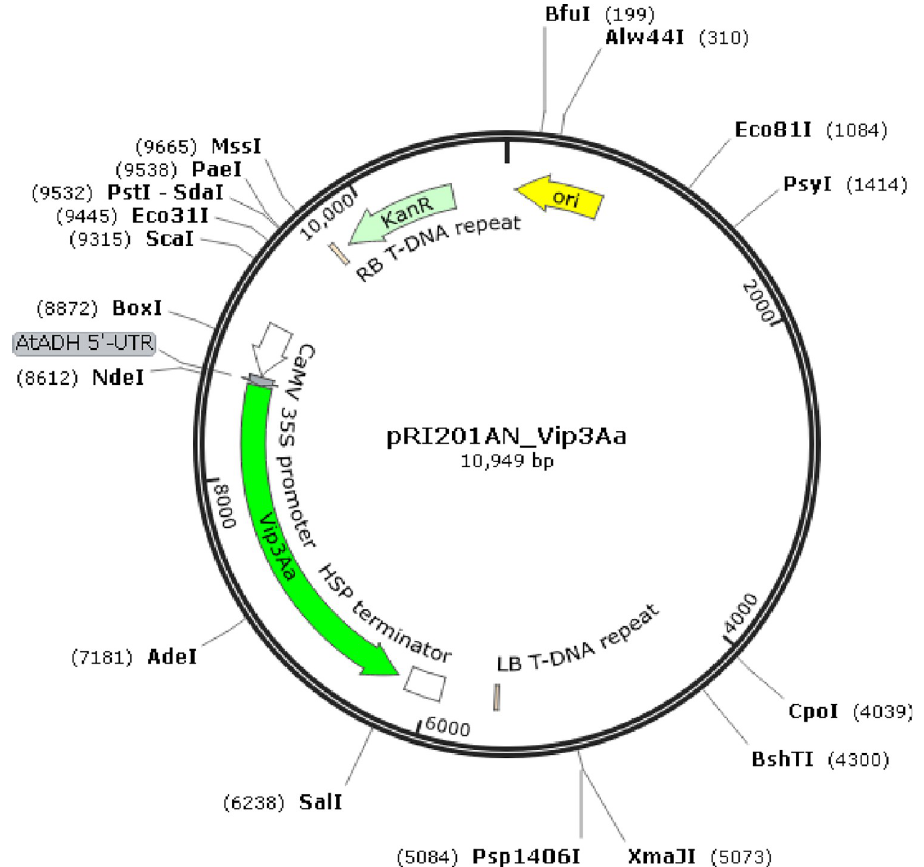
Fig 1. Modified plant expression vector pRI 201-AN harboring cm Vip3Aa